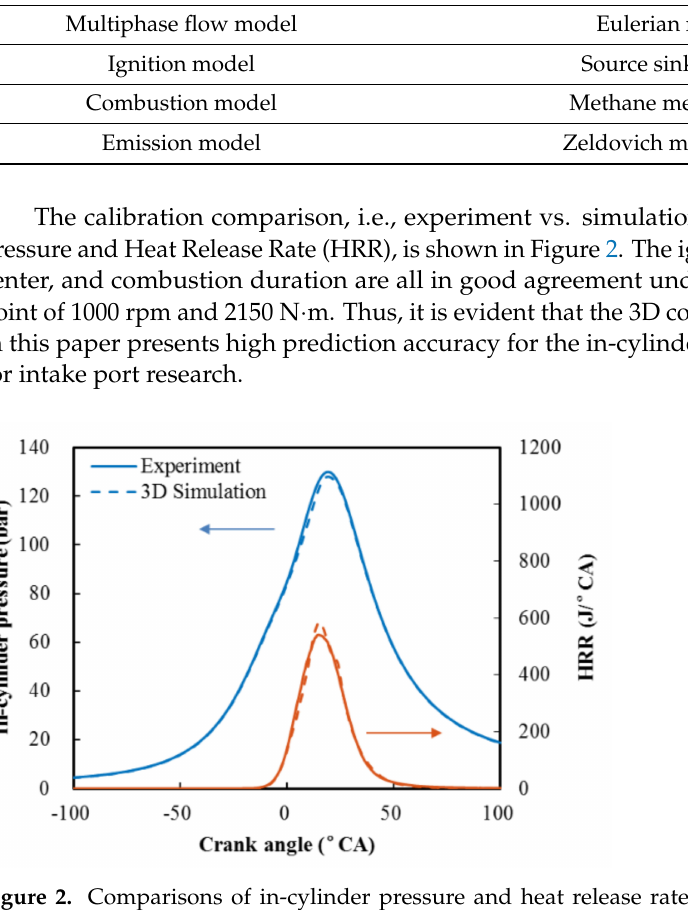
Figure 2. Comparisons of in-cylinder pressure and heat release rate between experiments and